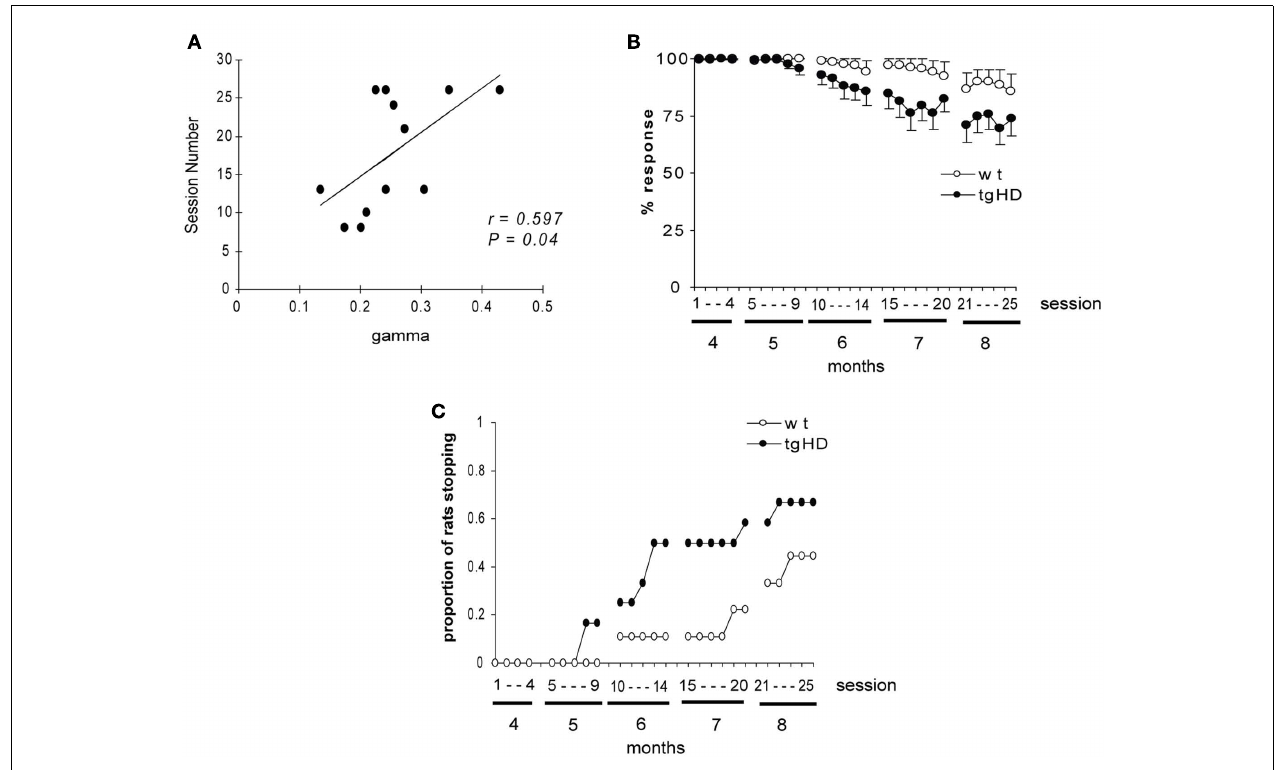
at 4months, for tgHD rats. (B) Mean ( ± SEM) percent responses to intermediate durations on the 25 sessions of testing in months 4–8 for tgHD (filled symbols) and wt (empty symbols) rats. (C) Proportion of rats in each group stopping to respond across the 25 sessions of